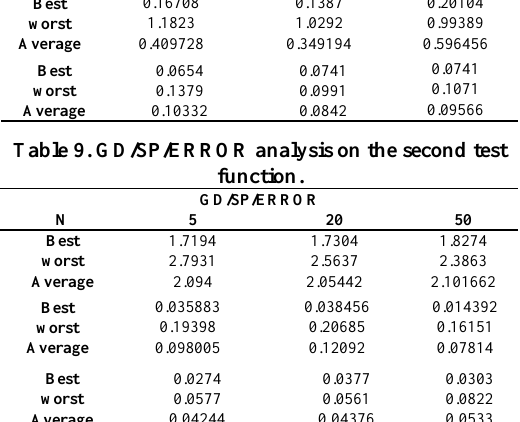
Table 13. GD/SP/ERROR analysis on the second test